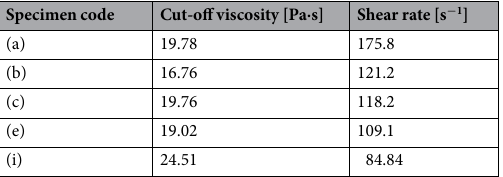
Table 1. Cut-off viscosity and the shear rate at the viscosity in Fig. 1. The cut-off viscosity can be a threshold of the maximum pressure limit for